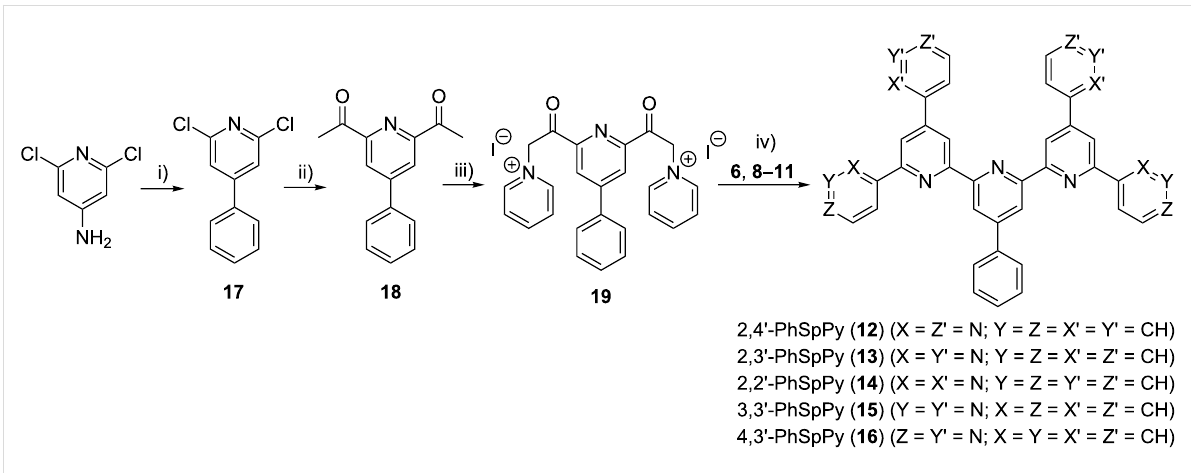
Scheme 2: Synthetic pathway to PhSpPys ( 12 – 16 ). i) Cu 2 O, isoamylnitrite, benzene, 100 °C, 3 h; ii) (1-ethoxy)-vinyl-tributylstannane, Pd(PPh 3 ) 4 , DMF, 20 h reflux, acetone, HCl; iii) iodine, pyridine, 100 °C, 4 h; iv) NH 4 OAc, MeOH reflux.